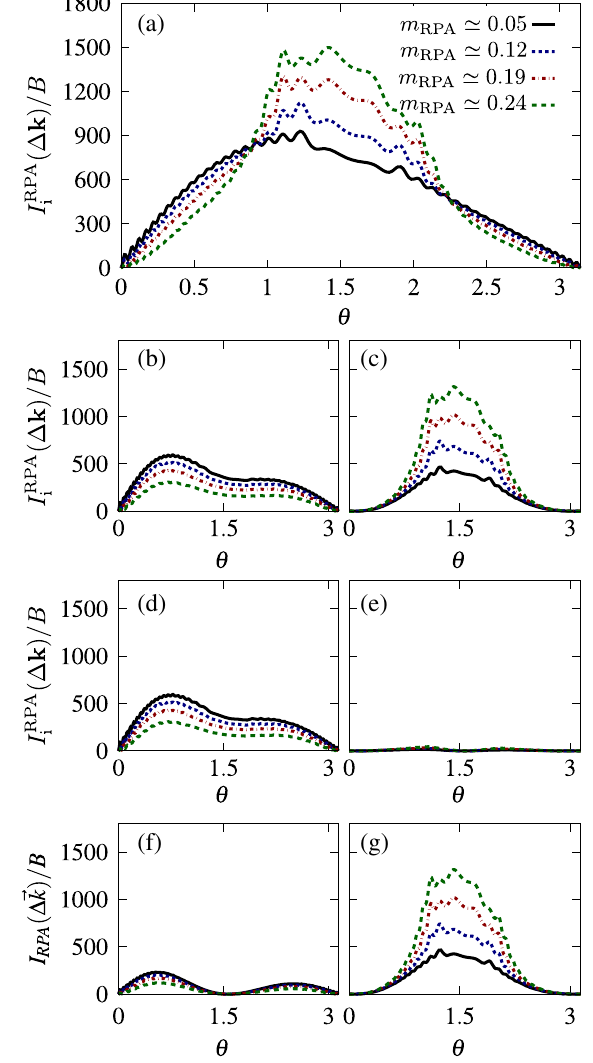
FIG. 21. Angular distribution of the inelastically scattered light intensity along the direction ϕ ¼ π = 4 when the scattered light is projected along specific polarization directions. We show different values of the interaction strength U at T ¼ 0 . The calculations are based on RPA, κ ¼ 1 . 5 , and the other param- eters are as in Fig. 11. (a) The total scattered light intensity; (b) the total scattered intensity from the spin-conserving transition; (c) the total scattered intensity from the spin- exchanging transition. In (d) and (e), the light has been projected along the direction of the scattered light from the spin-conserving transition. (d) Projected component of the scattered intensity from the spin-conserving transition, which in this case is equal to (b); (e) projected component of the scattered intensity from the spin-exchanging transition. In (f) and (g), the light has been projected along the direction of the scattered light from the spin-exchanging transition. (f) Projected component of the scattered intensity from the spin- conserving transition; (g) projected component of the scattered intensity from the spin-exchanging transition, which in this case is equal to